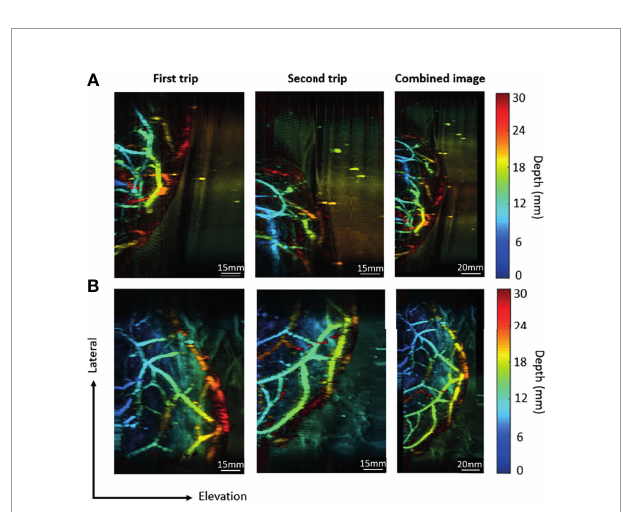
FIGURE 6 | Combination of images acquired in the round-trip scan. (A) The imaging results for a breast cup size of C. (B) The imaging results for a breast cup size of D. The fi rst trip covers the right portion of the breast, while the second trip covers the left portion of the breast. The last column contains combined images from two trips.